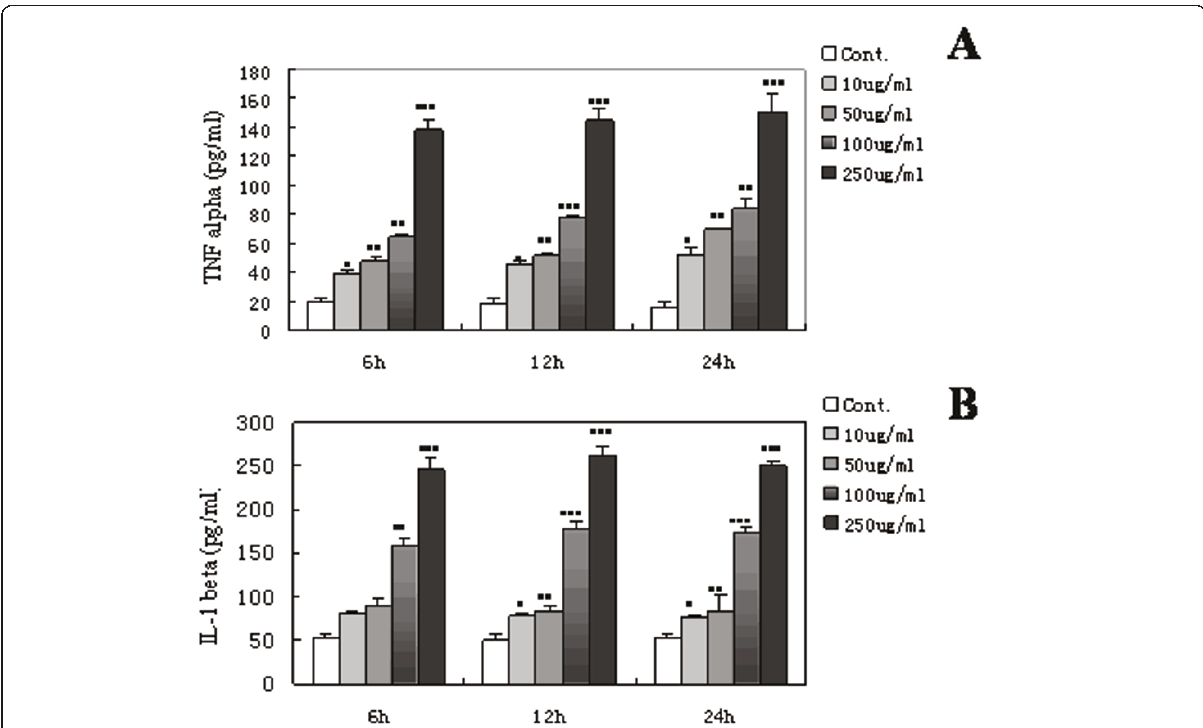
Figure 3 Cytokine release from purified microglial cells stimulated with glycated albumin (GA) for 6, 12, or 24 h . (A) The release of TNF- a from retinal microglial cells cultured with 0, 10, 50, 100, or 250 μ g/mL GA for various time periods. TNF- a in the culture supernatants began to increase at 6 h after exposure to 10 μ g/mL GA and peaked after exposure to 250 μ g/mL GA. (B) The release of IL-1 b from retinal microglial cells cultured with 0, 10, 50, 100, or 250 μ g/mL GA for various time periods. IL-1 b in the culture supernatants began to increase at 12 h after exposure to 10 μ g/mL GA and peaked after exposure to 250 μ g/mL GA. The results are shown as means ± SD of three individual experiments. One-way ANOVA was performed, followed by post-hoc analysis. *, P < 0.05; **, P < 0.001; ***, P < 0.0001.